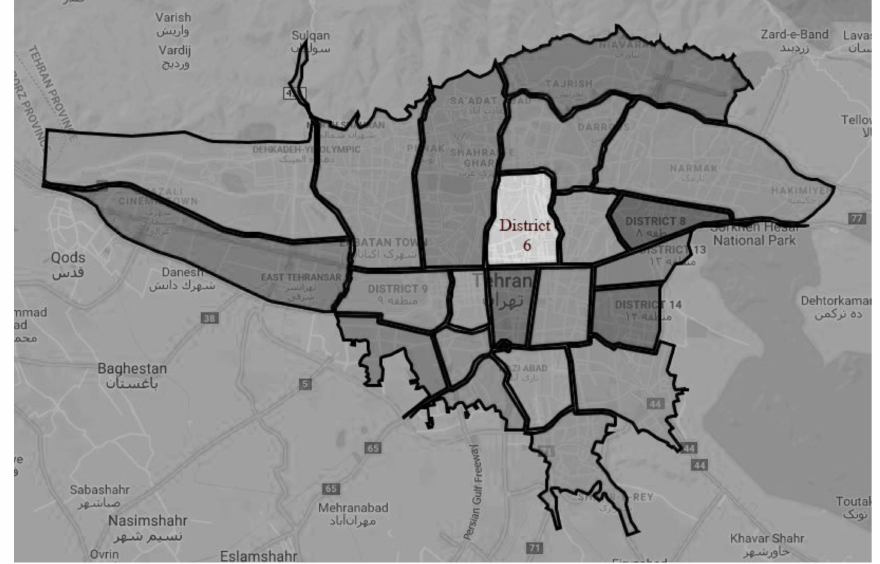
Figure 1. Map of the 6th district, located in the centre of Tehran. The other research area is in the Lisbon area at 42 ◦ 38 (cid:48) north latitude and 09 ◦ 08 (cid:48) west longitude, located in western Portugal on the estuary of the Tagus River along the Atlantic